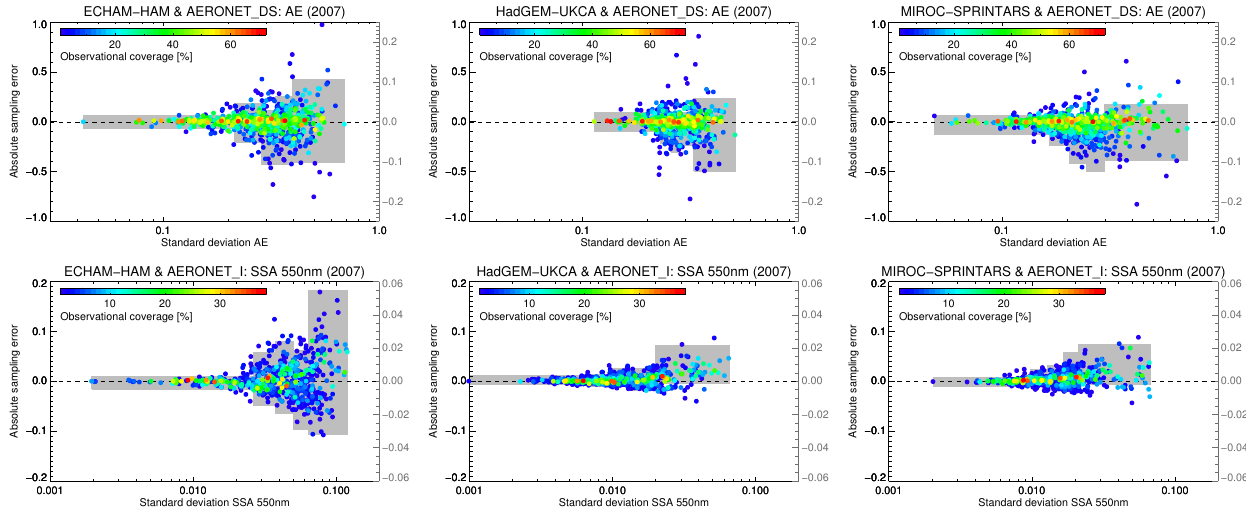
Figure 11. Absolute temporal sampling error for monthly mean AE and SSA using AERONET sampling, as a function of time series standard deviation and observational coverage. The grey boxes in the background (axis on the right), show the 25 and 75% quantiles of those errors for equally sized